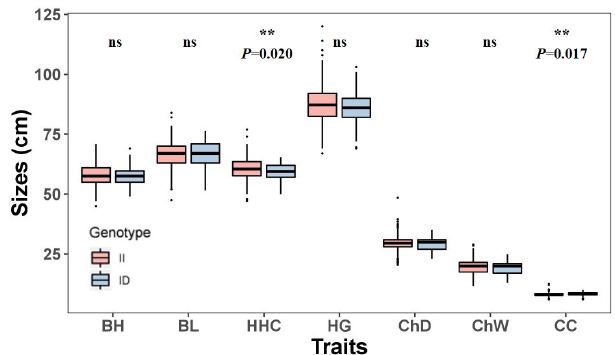
Figure 3. Association between the 20-bp indel locus of CDC25A gene and growth-related traits in SBWC goat. Note: BH, body height; BL, body length; HHC, height at hip cross; HG, heart girth; ChD, chest depth; ChW chest width; CC, cannon circumference.